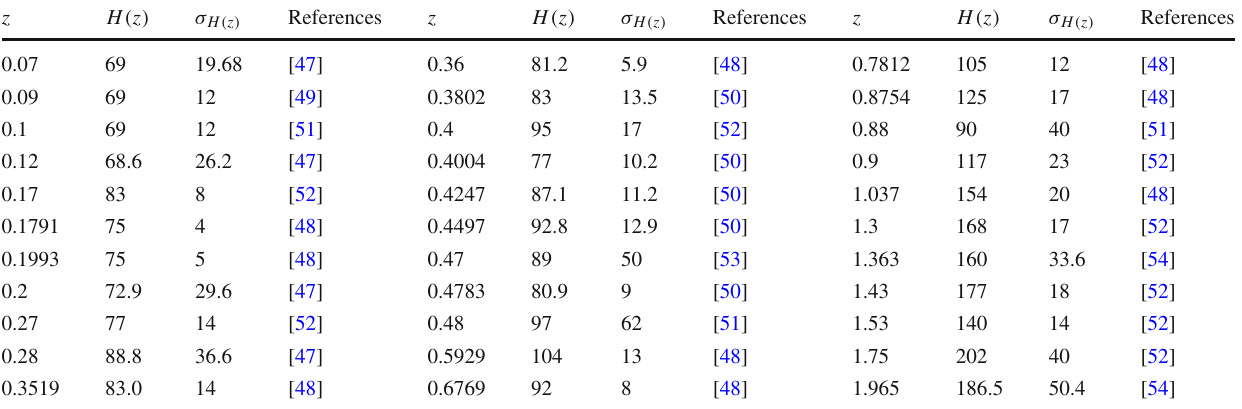
Table 1 Cosmic chronometers data used in this paper z